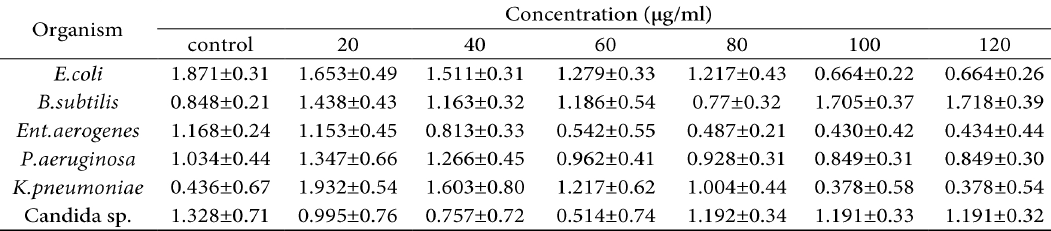
Table 2. Anti biofilm capacity of the biologically synthesized MnO